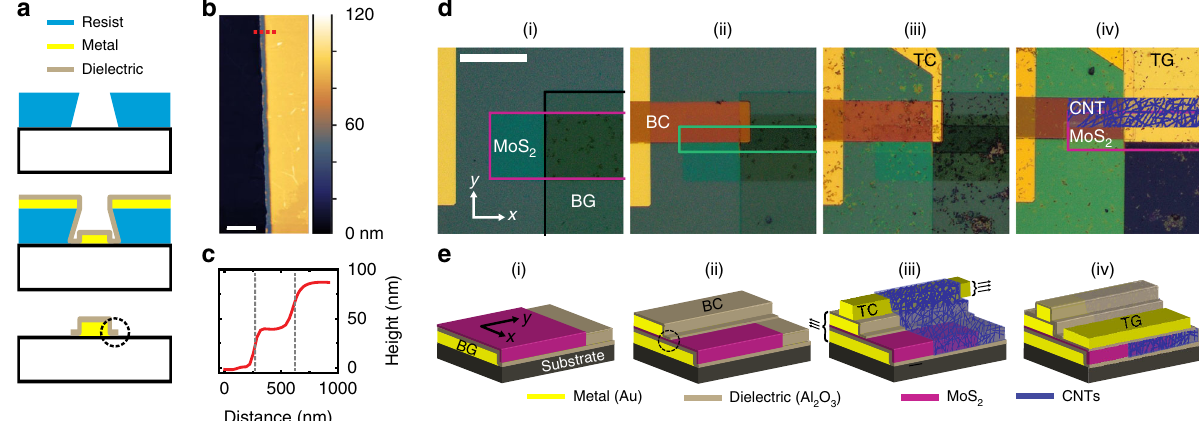
Fig. 1 Fabrication of Gaussian heterojunction transistors. a Photolithography-based self-aligned fabrication, which is enabled by resist undercuts that are controlled by spin-coating speeds, exposure time, and development time. b Atomic force microscopy topography image of an electrode and dielectric extension (2 µ m scale bar) corresponding to the dashed circle in a . c Height pro fi le corresponding to the dashed red line in b , revealing a sub-exposure- wavelength extension of ~300 nm on monolayer MoS 2 . d Optical micrographs of the fabrication process (50 µ m scale bar). e Three-dimensional rendering of the device structure throughout